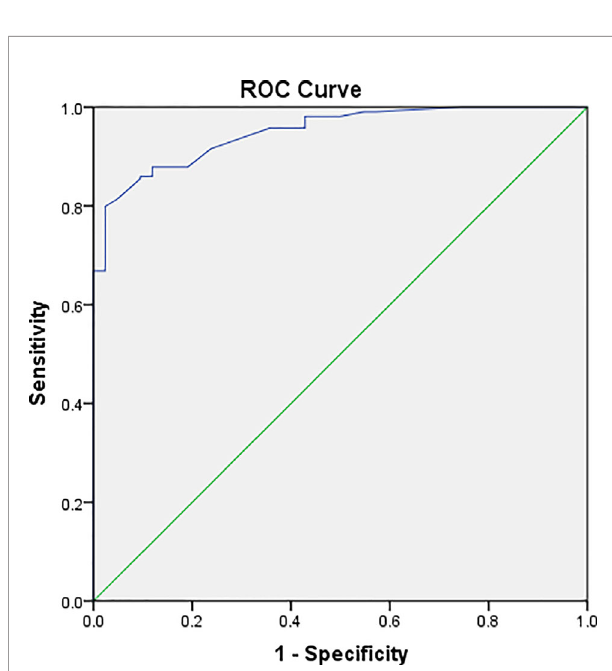
FIGURE 3 | Graph illustrating the result of ROC analyses. ROC analysis was performed according to the mean diameter of the nodules. ROC curve showed the diagnostic perfomance of PETRA sequence in detecting nodules, AUC=0.946. Nodules with a diameter greater than 6mm, the sensitivity and speci fi city of detecting are 85.5% and 99.5%.